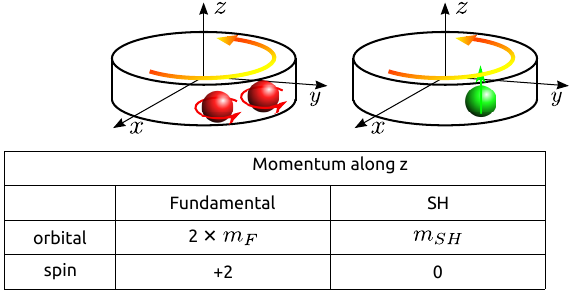
Figure A1. Illustration of the angular momentum given in ¯ h . Two fundamental photons (red), circularly polarized, are converted into one SH photon (green) linearly